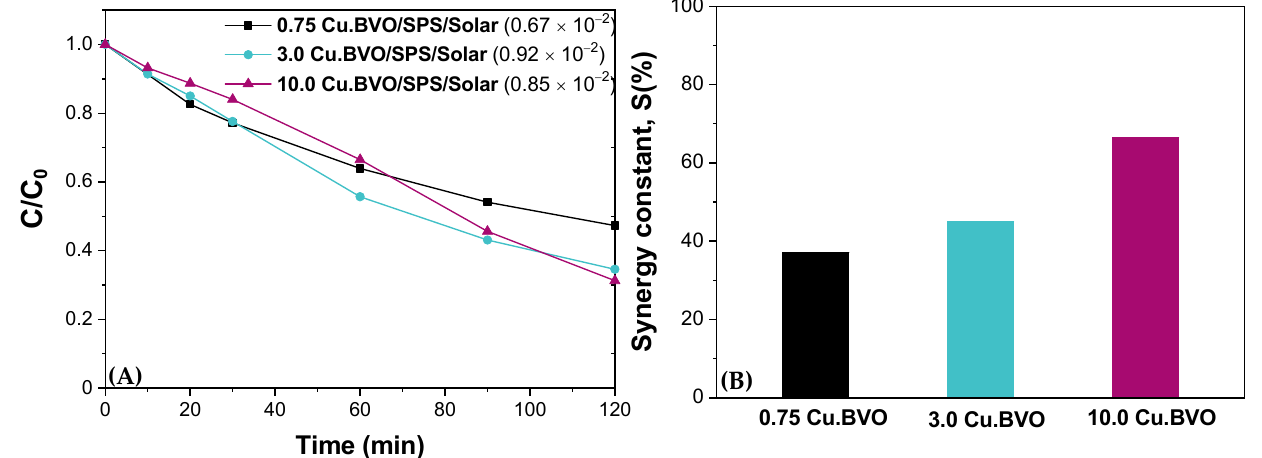
Figure 10. Effect of copper loading on ( A ) SMX removal and ( B ) k app in solar/SPS/catalyst systems in WW.